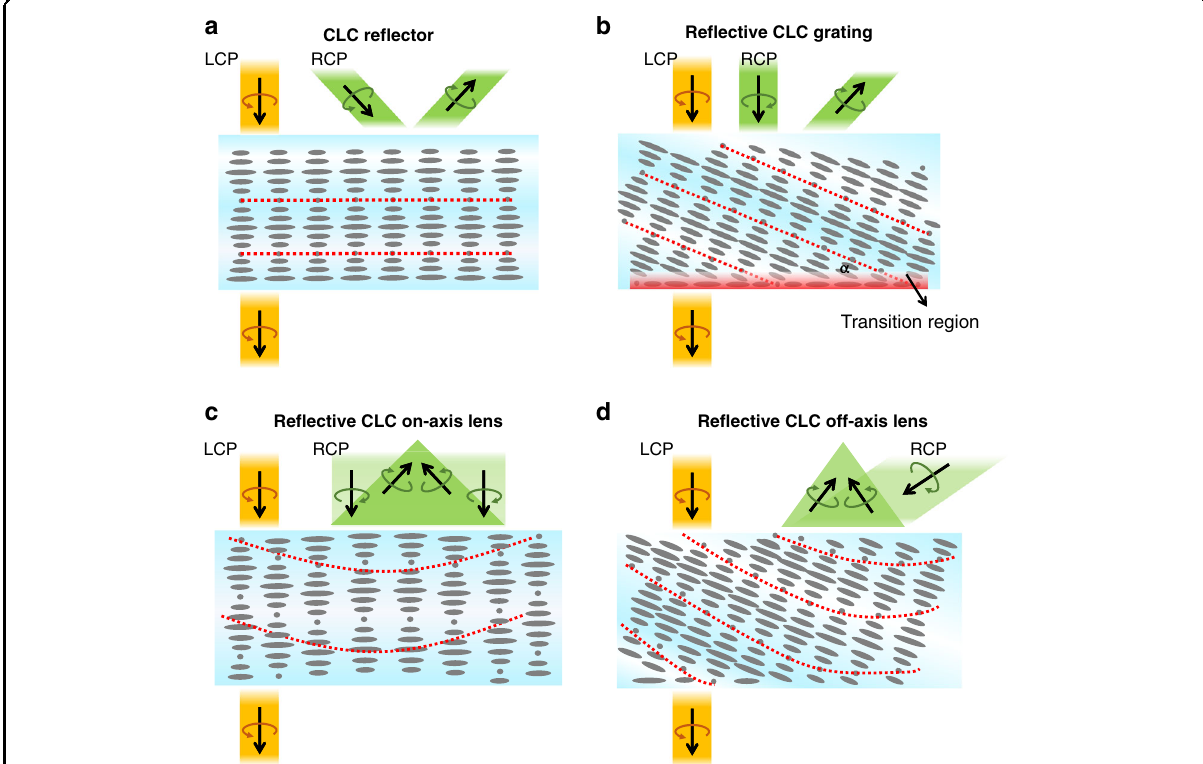
Fig. 12 Diagrams of polarization responses of various re fl ective LCOEs. a CLC re fl ector, b re fl ective CLC grating , c re fl ective on-axis CLC lens, and d re fl ective of-axis CLC